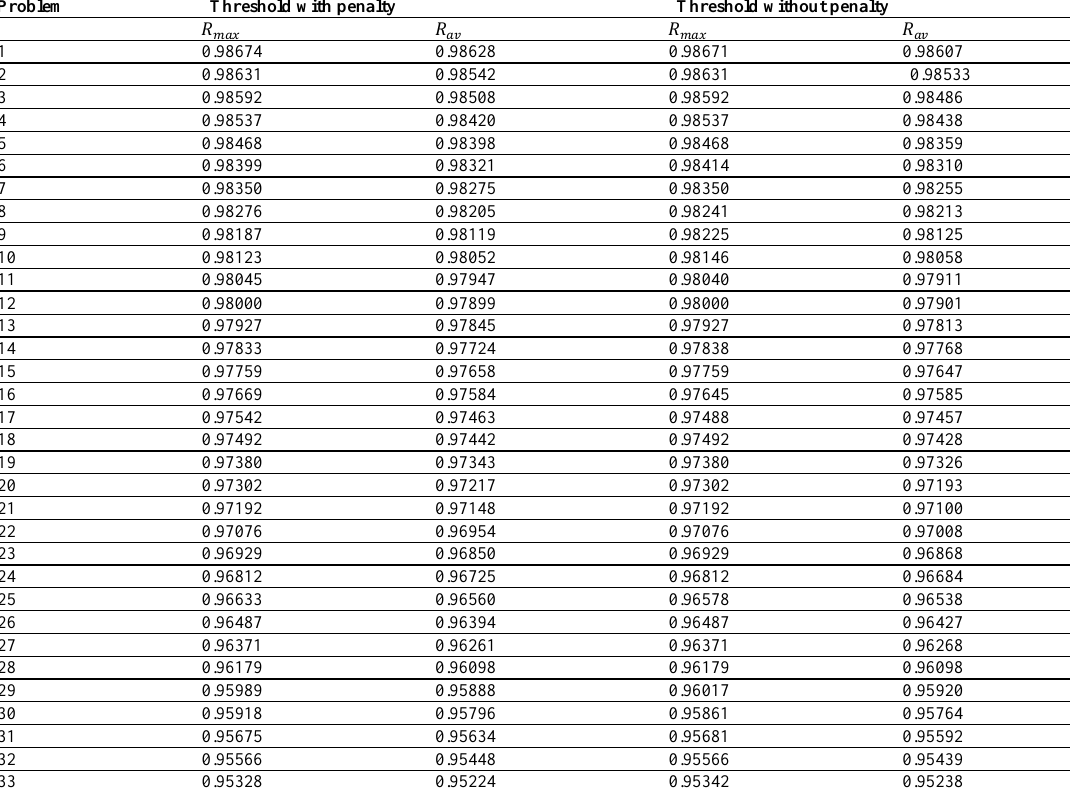
Figure 4. Effect of the penalty on NLTA in case of multi-state systems. Table 7. Results obtained by TA with and without penalty in case of binary-state